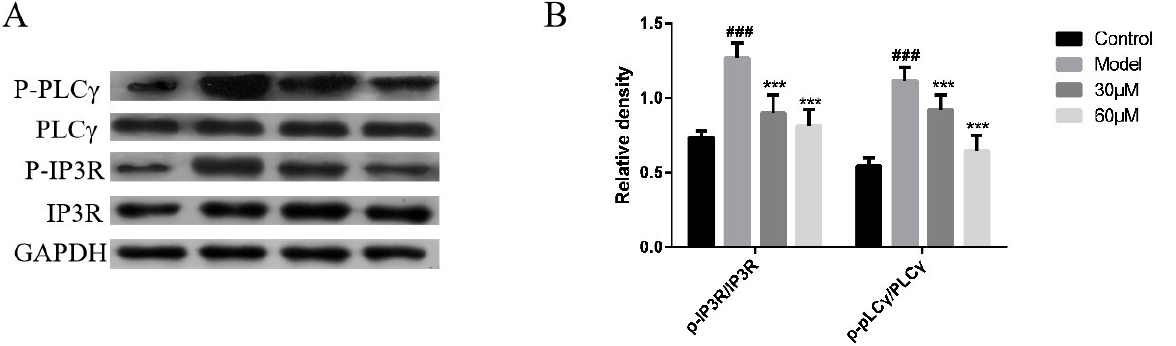
Figure 4. Effect of AT on Ca 2+ -related signaling pathway in C48/80-stimulated RBL-2H3 cells. ( A ). The expression of p-PLC γ , PLC γ , p-IP3R, IP3R, and GAPDH were analyzed by Western blot. ( B ). Quantification of the proteins in ( A ). The density of each band was quantified by Image J Software (ImageJ 1.50e). The data are presented as the mean ± S.D. *** p < 0.001 versus the model group. ### p < 0.001 versus the control group, n = 3.